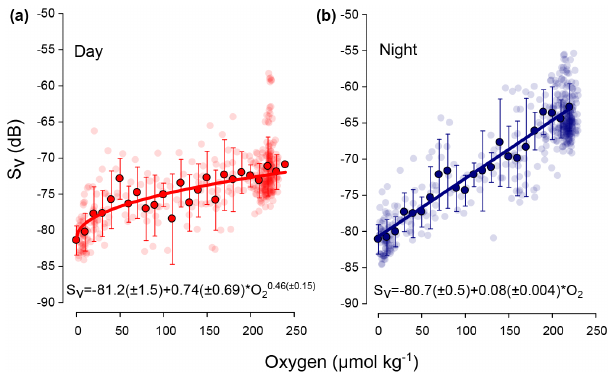
Figure 3. Moored ADCP (300kHz, matched to depth of moored oxygen sensor, approximately 50m) mean volume backscatter S v (dB) as a function of oxygen concentration (µmolO 2 kg − 1 ) dur- ing daytime (a) and nighttime hours (b) . Higher S v indicates a higher biomass of zooplankton and nekton. Transparent symbols are 1.5-hourly data, filled symbols are mean values ( ± SD) for 10µmolO 2 kg − 1 bins. Data are from 1 January to 14 March